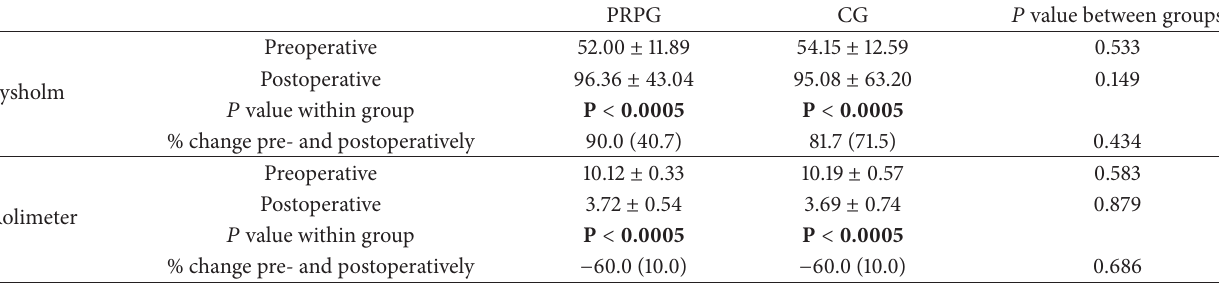
Table 2: Comparison of Lysholm and Rolimeter variables between groups during the observation period.